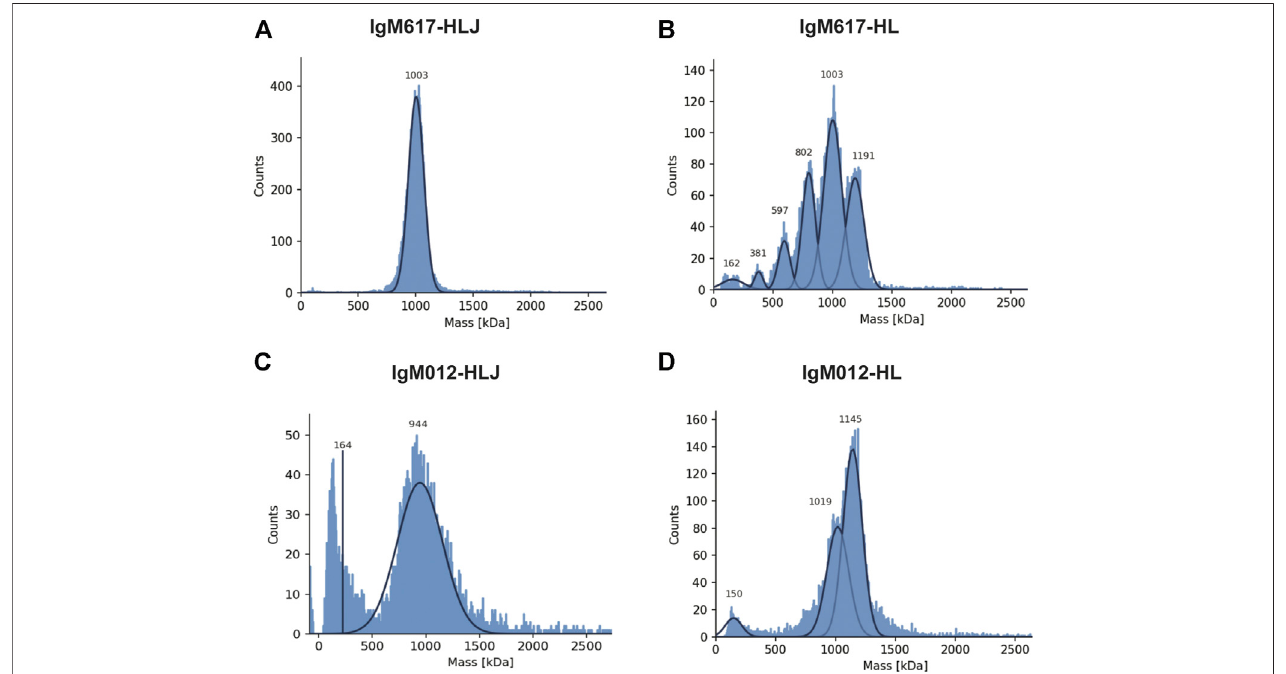
FIGURE 3 | Mass photometry (MP) analysis of recombinant IgMs produced in HEK293F. Histograms show the population distributions of puri fi ed IgMs. Shown analysesarerepresentativeofreplicateexperiments: (A) IgM617-HLJ, (B) IgM617-HL, (C) IgM012-HLJ,and (D) IgM012-HL.Estimatedmolecularweightsfortheshown experiments are indicated on each